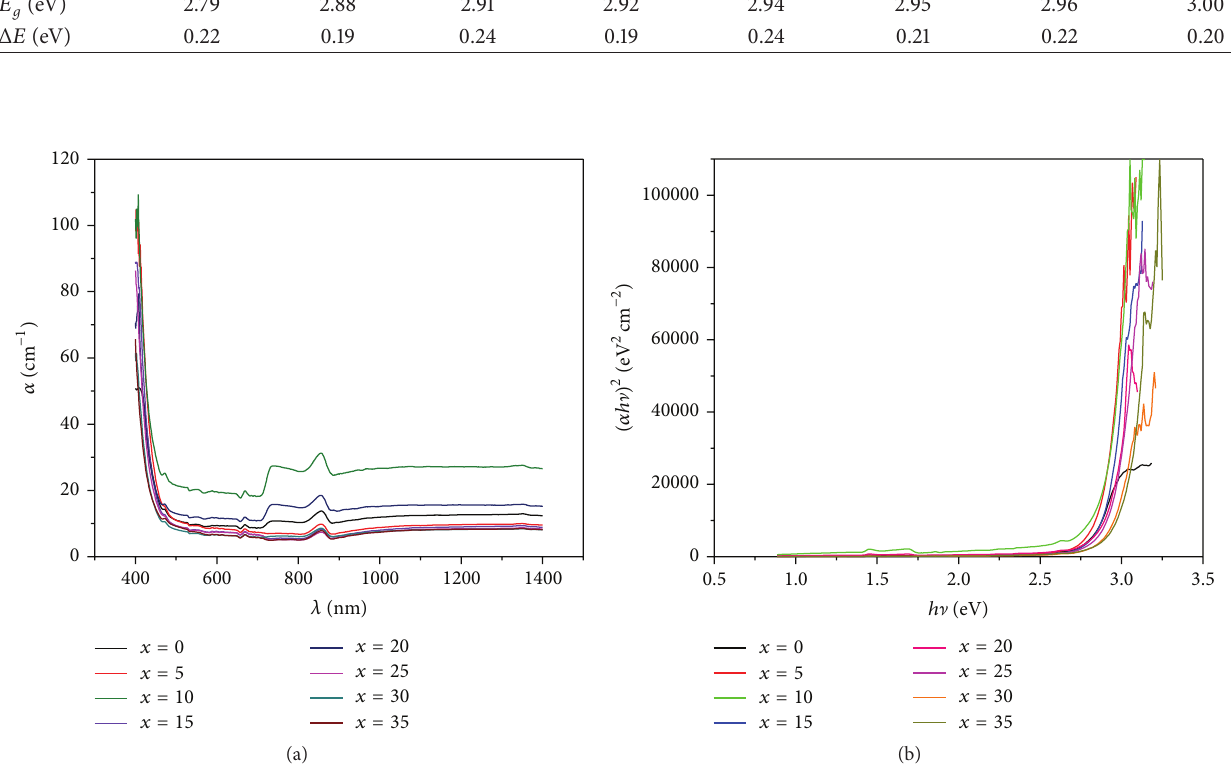
Figure 2: (a) Variation of absorption coefficient ( 𝛼 ) with wavelength ( 𝜆 ) of 40SiO 2 ⋅ 𝑥 ZnO ⋅ ( 60 − 𝑥 )Bi 2 O 3 glass system with 𝑥 = 0 , 5, 10, 15, 20, 25, 30, and 35; (b) Tauc’s plot for different glasses for 𝑟 = 1/2 in